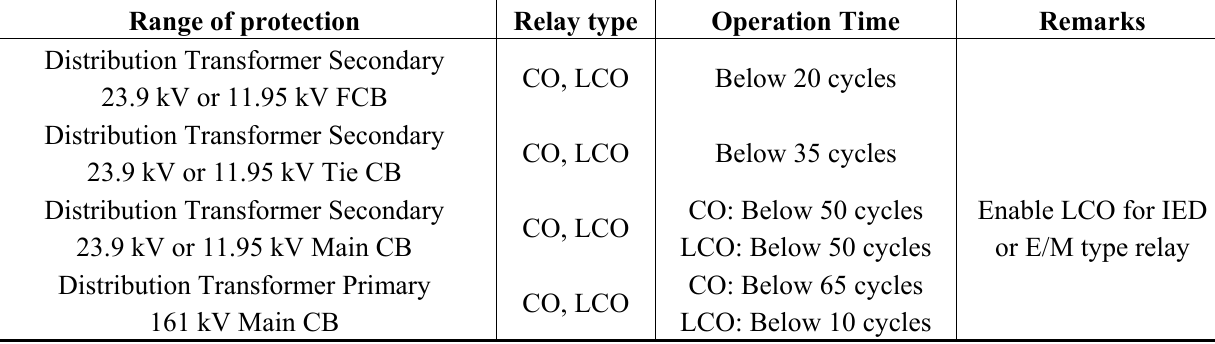
Table 1. Distribution substation distribution transformer feeder protective relay setting criteria.